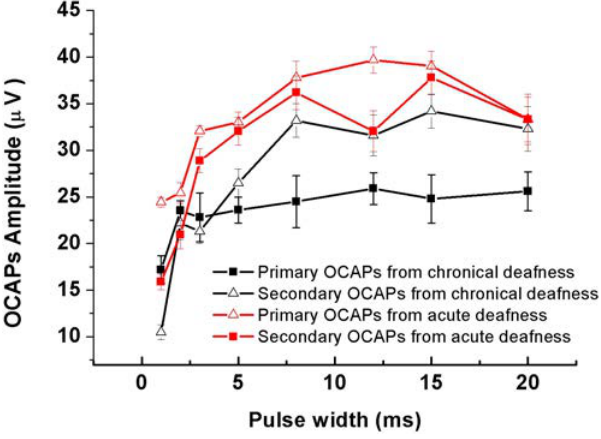
Fig. 6. Statistic results of OCAPs amplitudes obtained upon di®erent pulse width (1, 2, 3, 5, 8, 12, 15, 20 ms). The red lines and black lines stand for acutely and chronically deafened guinea pigs respectively, n ¼ 5.